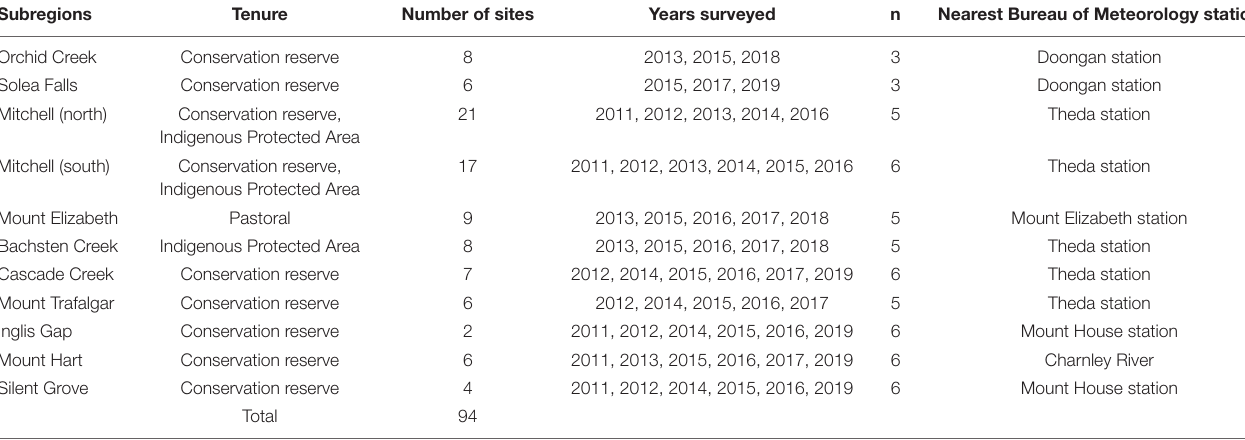
TABLE 1 | Summary of survey sites, tenure, and survey frequency and Bureau of Meteorological Stations used for rainfall data. Subregions Tenure Number of sites Years surveyed n Nearest Bureau of Meteorology